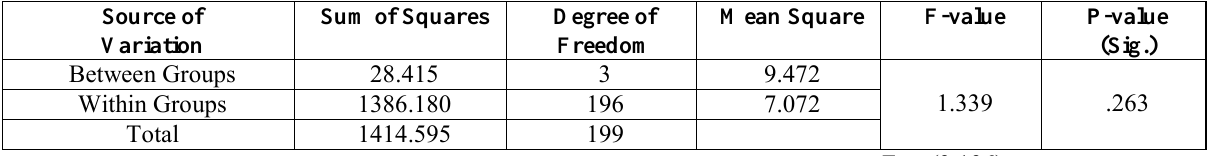
Figure 1. Graphical representation of mean scores with regard to North, East, West and South regions female baseball players on the sub-parameter Empathy Analysis of Variance (ANOVA) results among North, East, West and South regions female baseball players with regard